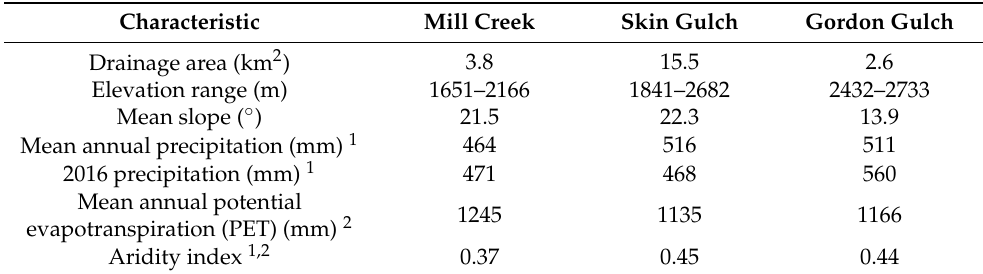
Table 2. Field survey summaries, with dates in 2016, area-normalized stream discharge at the